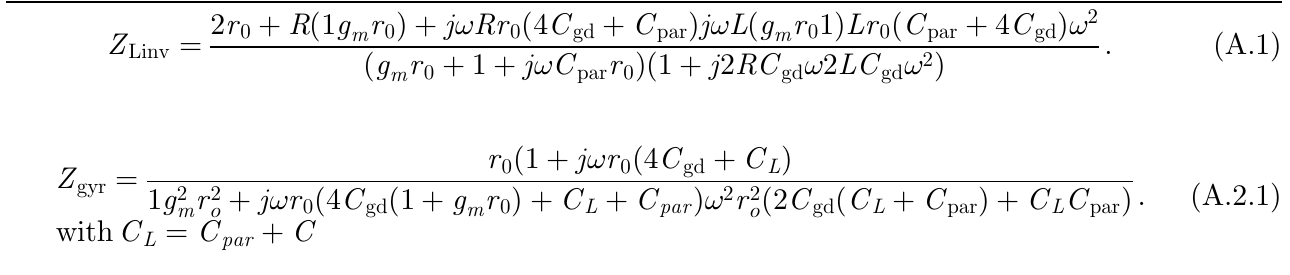
Figure A.2 for a speci fi c case ( g same parameters as Figure 10). All other parameters are